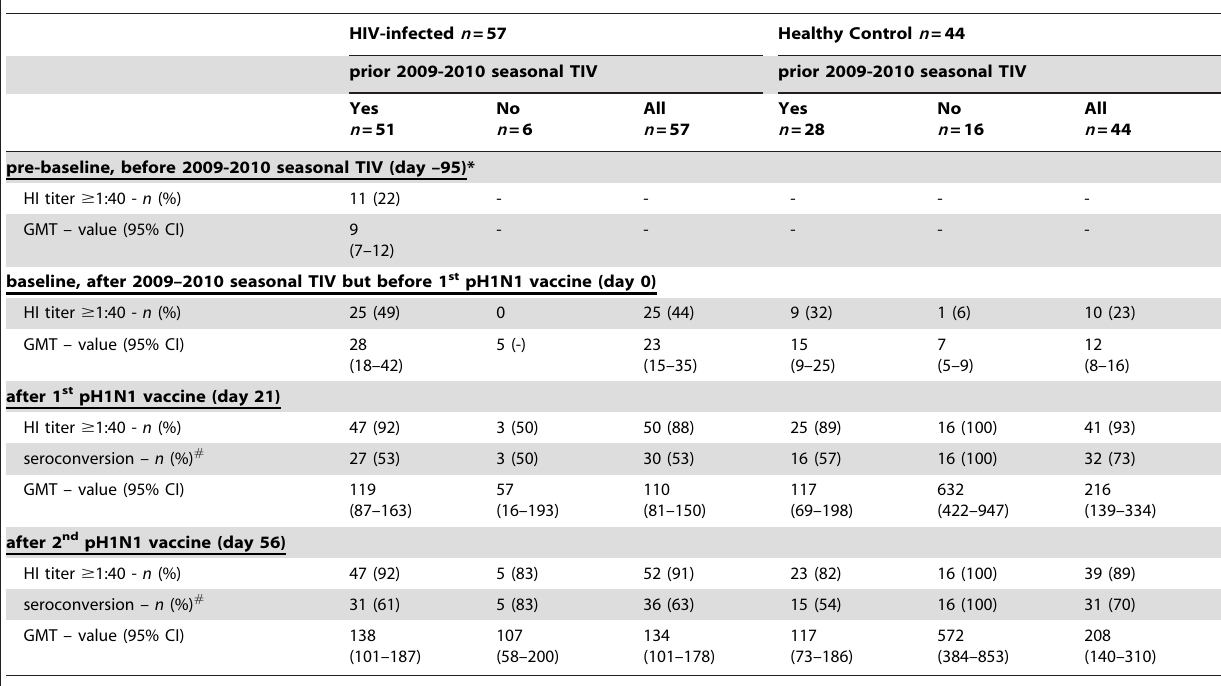
Table 2. Humoral immune response to two doses of pH1N1